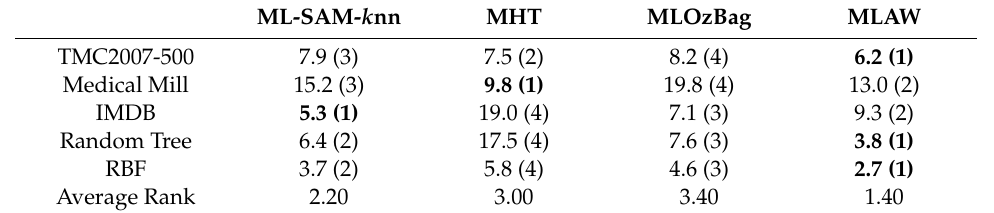
Table 6. Log-Loss of di ff erent algorithms.